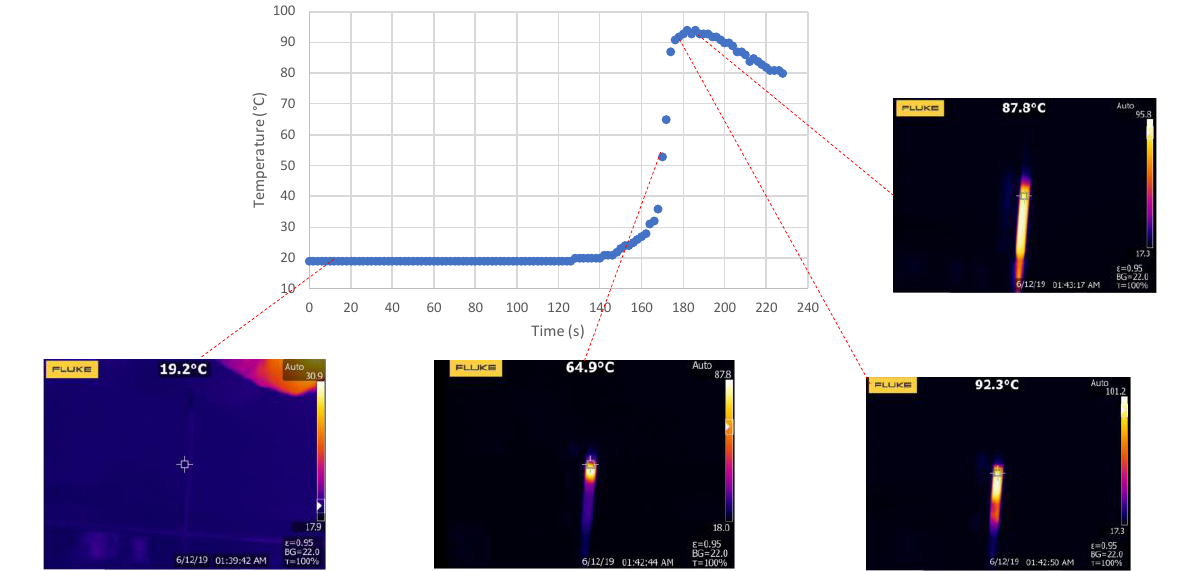
Figure 3. Optical pyrometric measurements (temperature vs. time after mixing; 4 mm thick sample) under air for the BM resin for Redox FRP using the T4epa/Iod (2%/0.6% w/w ) RIS and the associated thermal imaging pictures at different times.